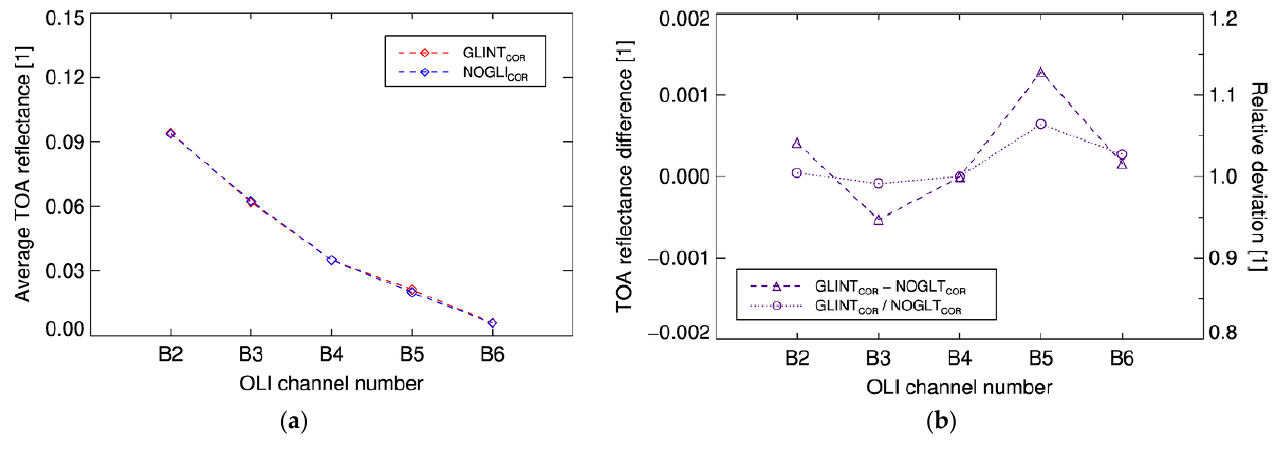
Figure 8. ( a ) Average TOA reflectance for sample scene BRS-3 after GRCM application in OLI channels B2 to B6 for glint-affected pixels (red) and neighboring glint-free pixels (blue); ( b ) Absolute (dashed, left axis) and relative (dotted, right axis) differences between glint-affected and neighboring glint-free pixels.